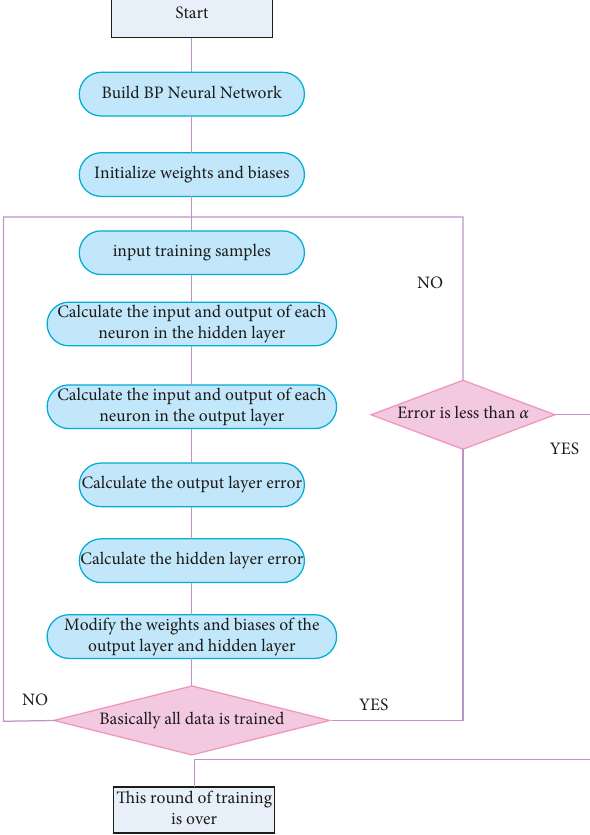
Figure 6: BP neural network algorithm